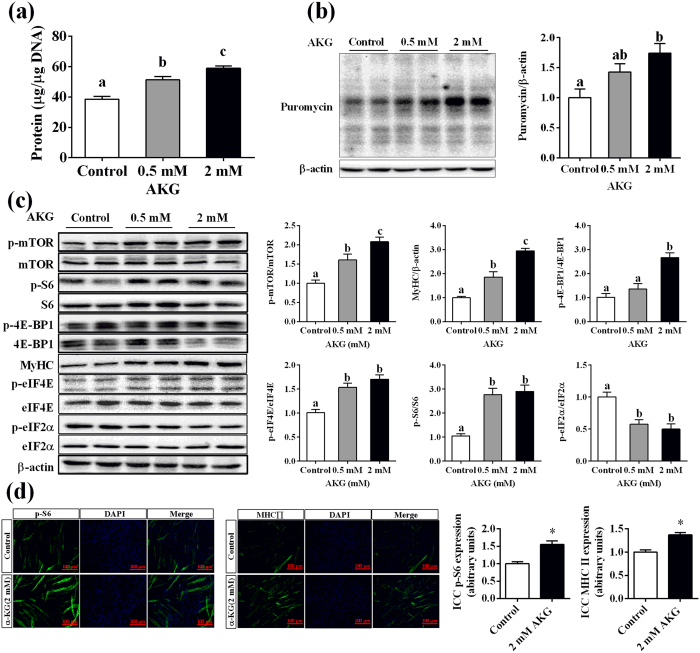
AKG increased protein synthesis in C2C12 myotubes. C2C12 cells were cultured for 6 d in a differentiation medium. C2C12 myotubes were then exposed to different concentrations of AKG (0, 0.5, and 2 mM) for 48 h. (a) Total protein levels. (b) Puromycin levels detected in C2C12 myotubes by Western blot. (c) The phosphorylation levels of mTOR, S6, 4E-BP1, eIF4E, eIF2a, and MyHC by Western blot. (d) IHC analysis for MHCII and phospho-S6 in C2C12 myotubes. Data are presented as mean±S.E.M. Different superscripts “a”/“b”/“c” represent significant differences between groups (P < 0.05), and * means P < 0.05 compared with the control. β-actin served as a housekeeping gene.